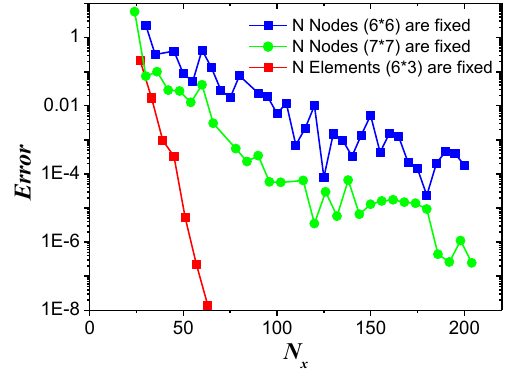
Fig. 3. The error of the reflected zero order for the grating of Fig. 1a) versus total number of nodes along axis x